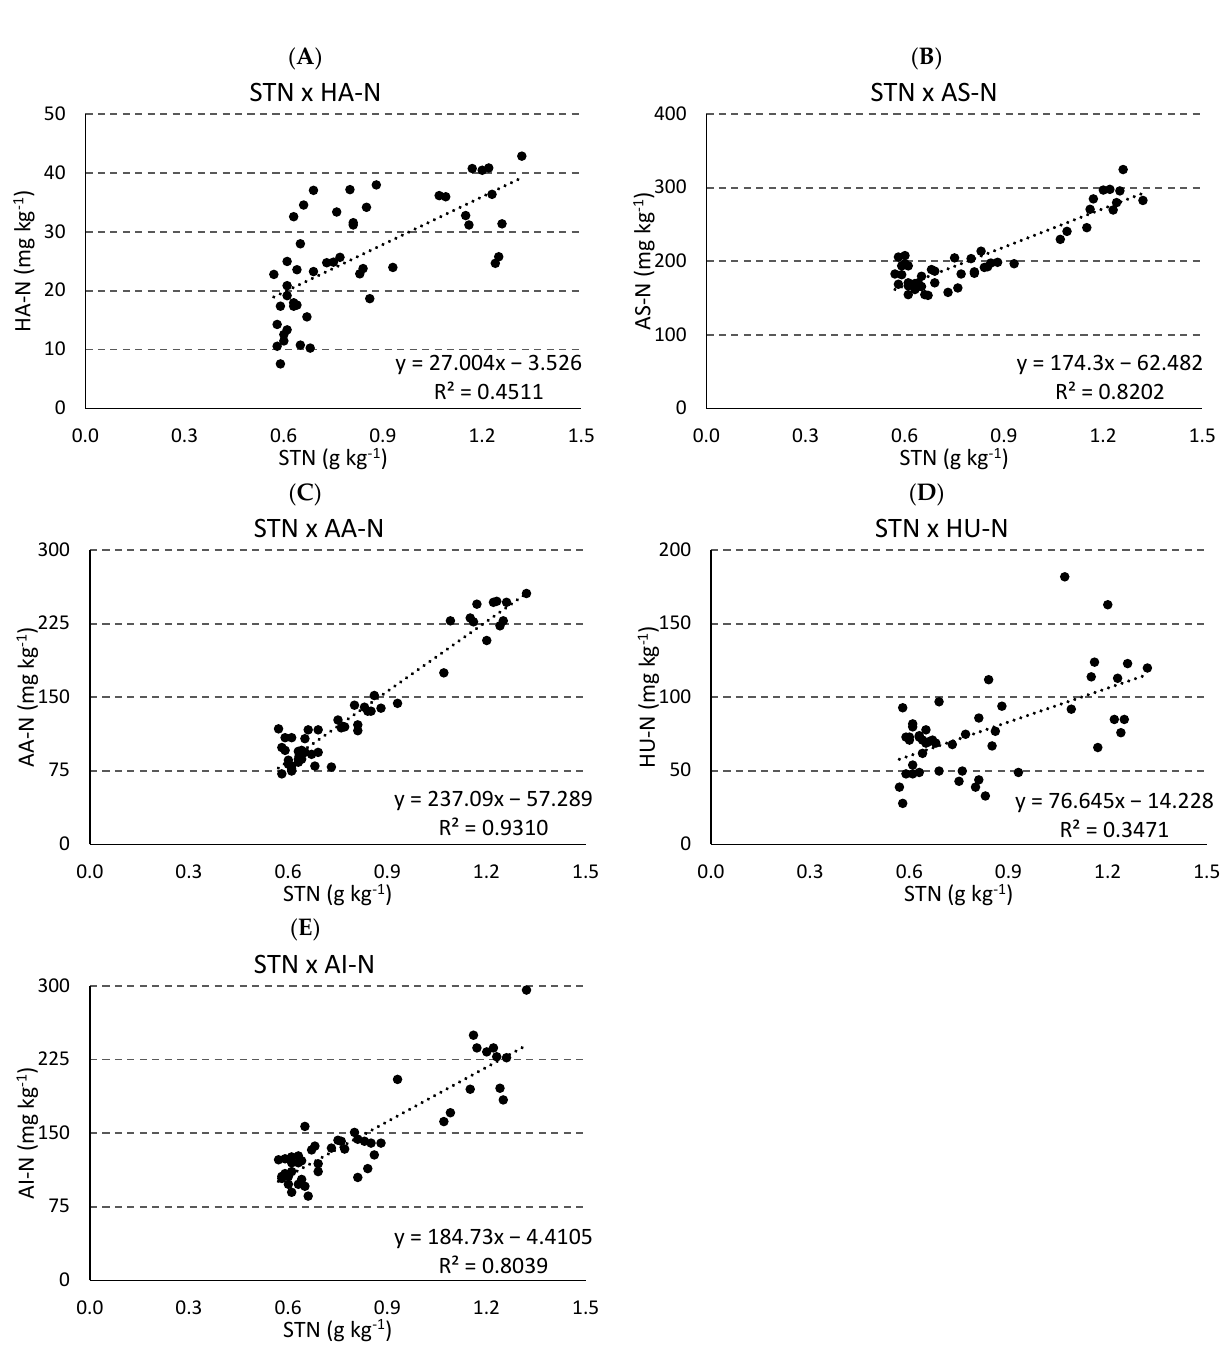
Figure 2. Linear relationship between soil total nitrogen and soil nitrogen fractions; hydrolyzable ammonium ( A ), amino sugar ( B ), amino acids ( C ), hydrolyzable unidentified ( D ), and acid insoluble ( E ). Equations and coefficients of determination are displayed in each graph.